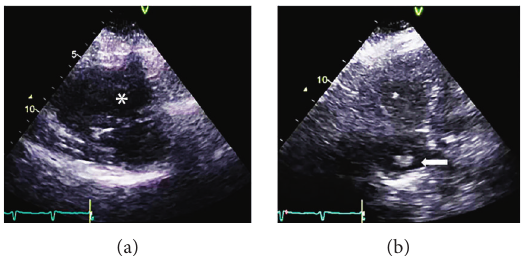
Figure 2: Echocardiography before thrombolysis showed severe right ventricular dysfunction with flattened intraventricular septum ( ∗ ) in parasternal short-axis view (a) and thrombus (arrow) in the right atrium in apical four-chamber view (b).